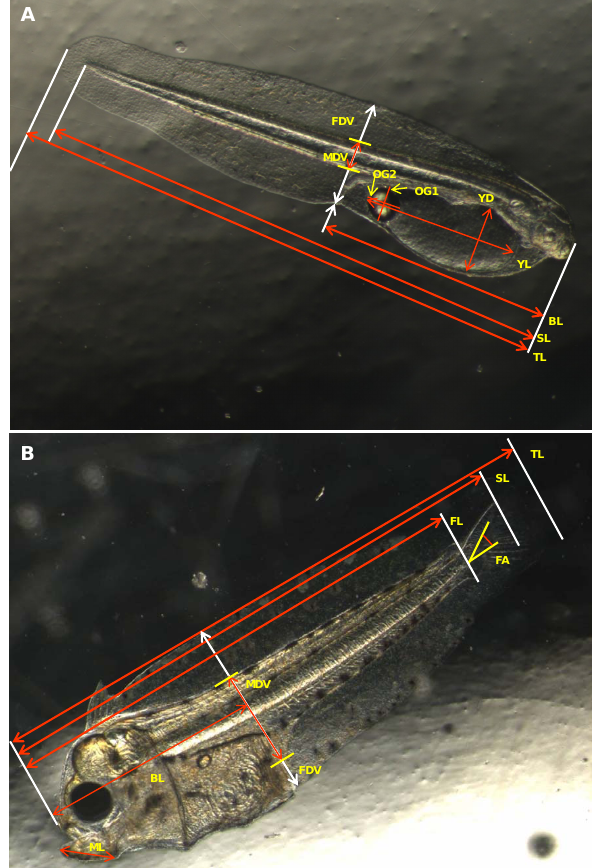
Fig. 1. Morphological variables used to describe size, shape, and development of summer flounder larvae in CO 2 effects experiment. Data were extracted from images of anesthetized live larvae in lat- eral perspective. The variables measured varied with larval age. (A) Yolk-sac larva at 0dph. (B) Advanced larva (28dph) undergoing no- tochord flexion. Abbreviations: total length (TL), standard (or no- tochord) length (SL), flexion length (FL), precaudal body length (BL), total body depth at vent (including finfold or fin integument) (FDV), muscle mass depth at vent (MDV), yolk length (YL), yolk depth (YD), oil globule diameters (OG1, 2), mandible length (ML), flexion angle